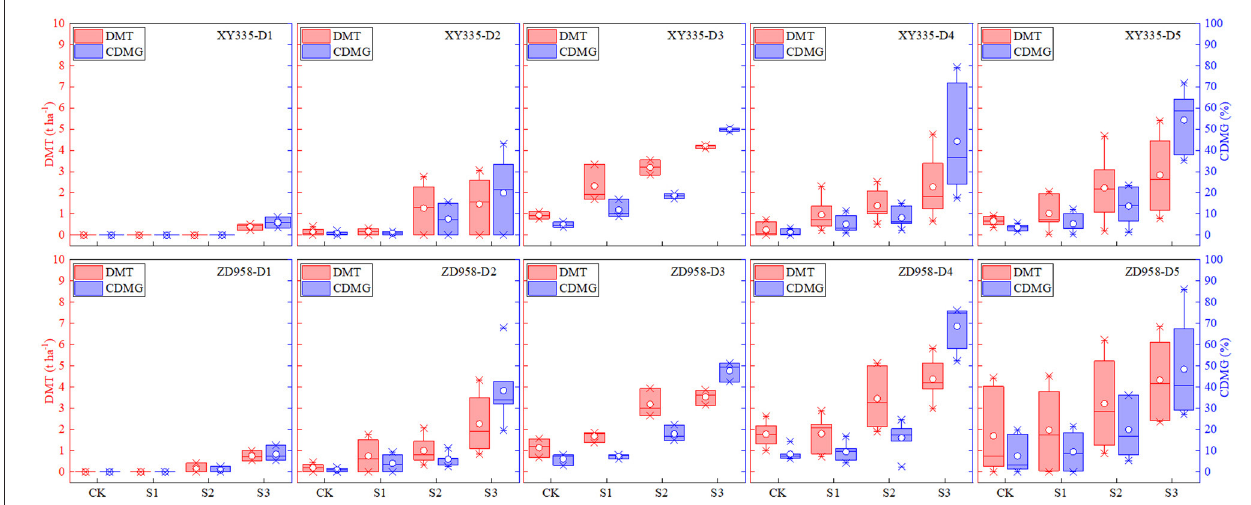
FIGURE 1 | Effects of different shading levels (CK, natural light; S1, 15% natural light; S2, 30% natural light, S3, 50% natural light) on vegetative organ dry matter translocation (DMT) and pre-silking dry matter contributions to grain (CDMG) under different planting densities (D1, 4.5 × 10 4 plants/ha; D2, 7.5 × 10 4 plants/ha; D3,